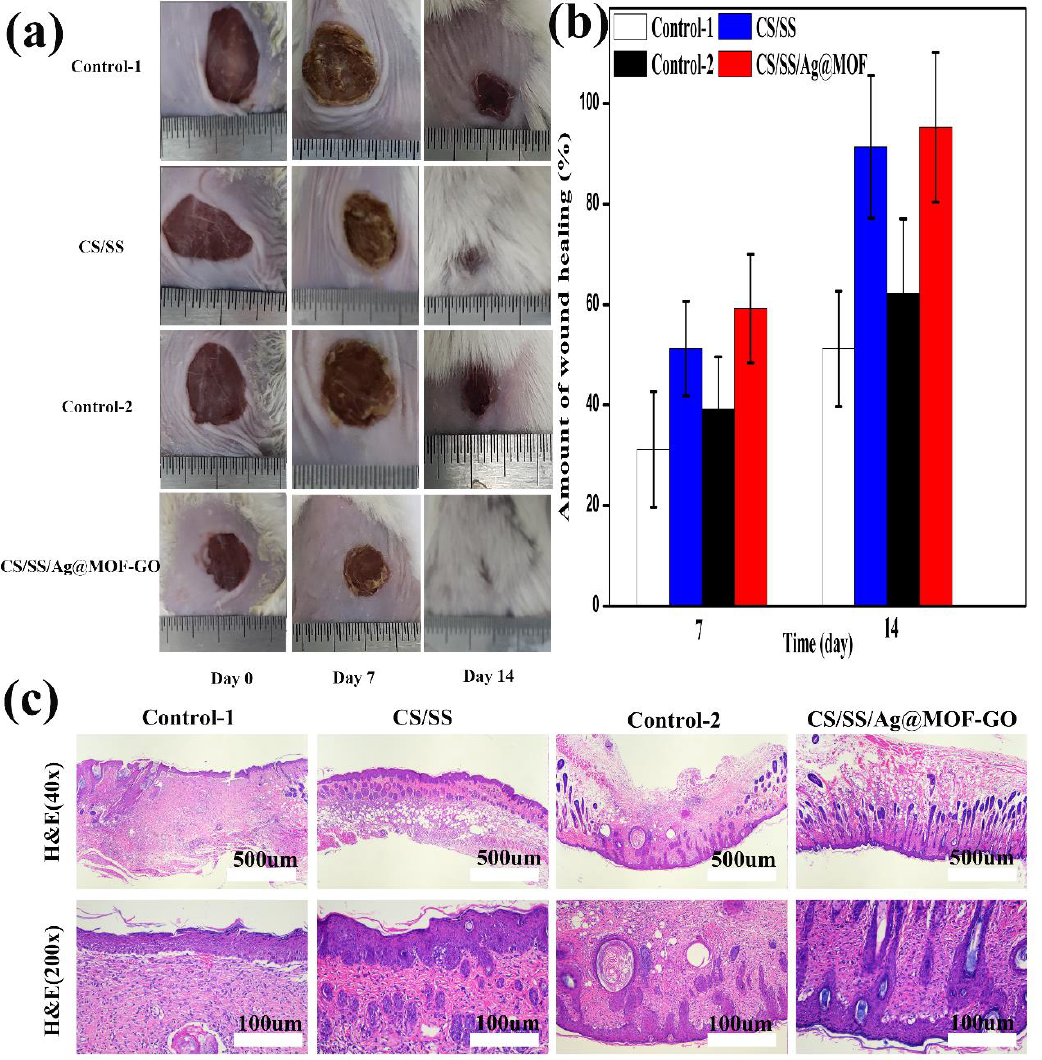
Figure 10. Photographs of wounds treated with the dressings, ( a ) wound treated with control-1, CS/SS, control-2, and CS/SS/Ag@MOF–GO for days, and ( b ) evaluation of the wounds area closure at 7 and 14 days; Micrographs of wound tissues stained with H&E ( c ).